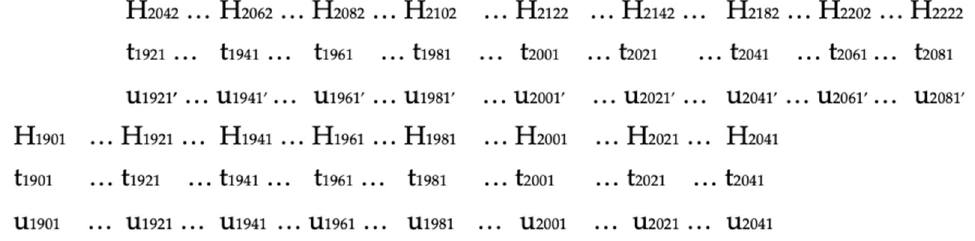
Figure 2. A hypertemporal universe with one instance of time travel.